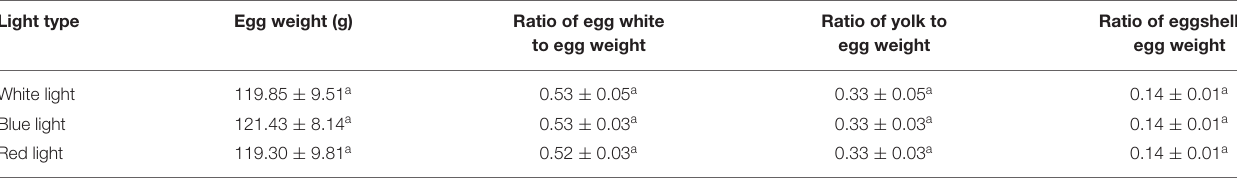
TABLE 4 | Effects of different color light on egg weight and its composition of